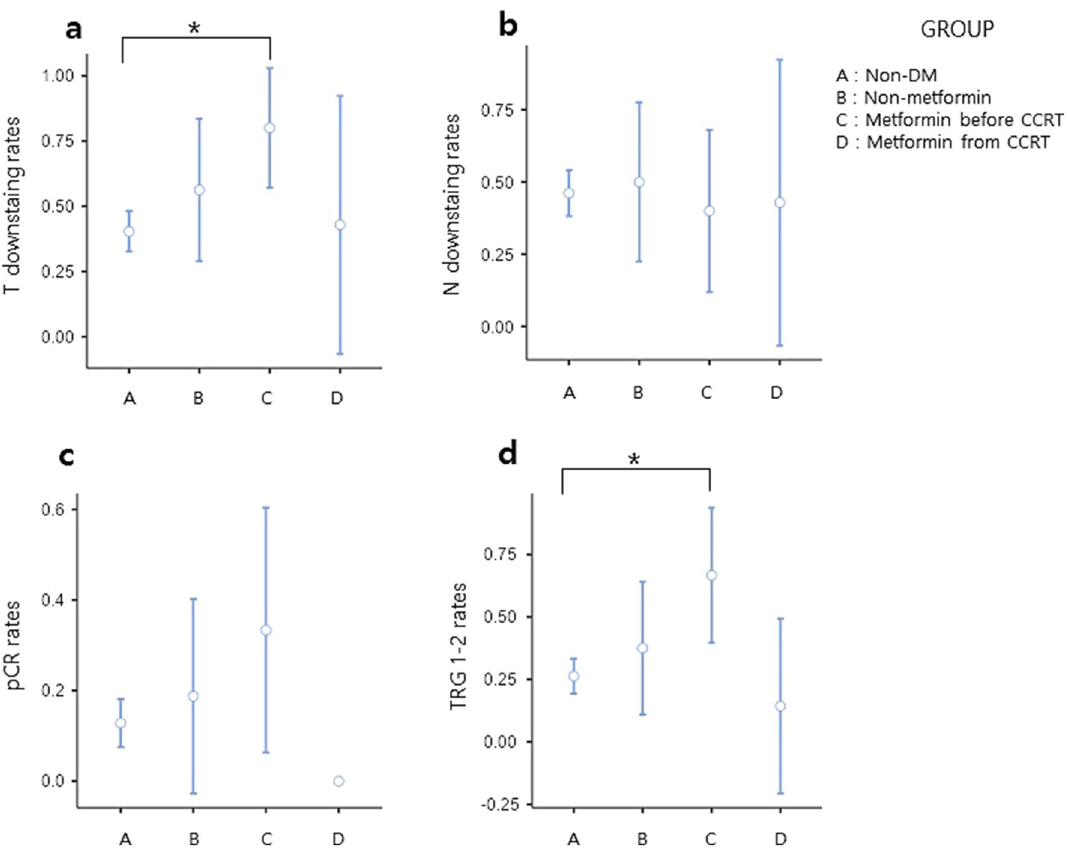
Figure 2. Tumor response rates between groups. ( a ) T downstaging, ( b ) N downstaging, ( c ) pathologic complete response, ( d) tumor regression grade, * p <